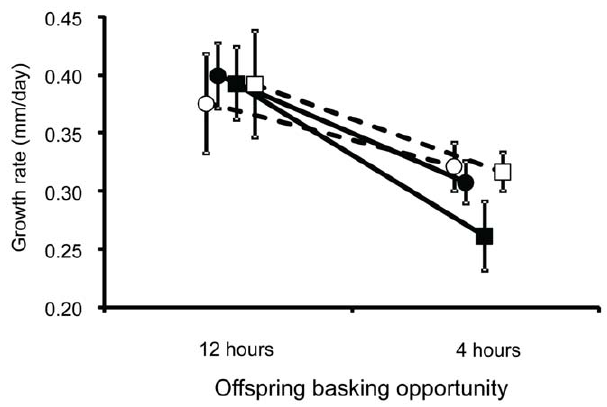
N Figure 3. Offspring growth rate over five weeks in Pseudemoia : Offspring from entrecasteauxii under the two thermal regimes. females given 12 hours basking opportunity with high food availability during gestation. # : Offspring from females given 12 hours basking opportunity with low food availability during gestation. & : Offspring from females given 4 hours basking opportunity with high food availability during gestation. % : Offspring from females given 4 hours basking opportunity with low food availability during gestation. Sample N sizes among offspring given 12 hours basking opportunity per day are N =17, # =13, & =16 and % =14. Sample sizes among offspring =18, # =17, & =13 given 4 hours basking opportunity per day are and % =12. Values are means 6 S.E. Some overlapping points have